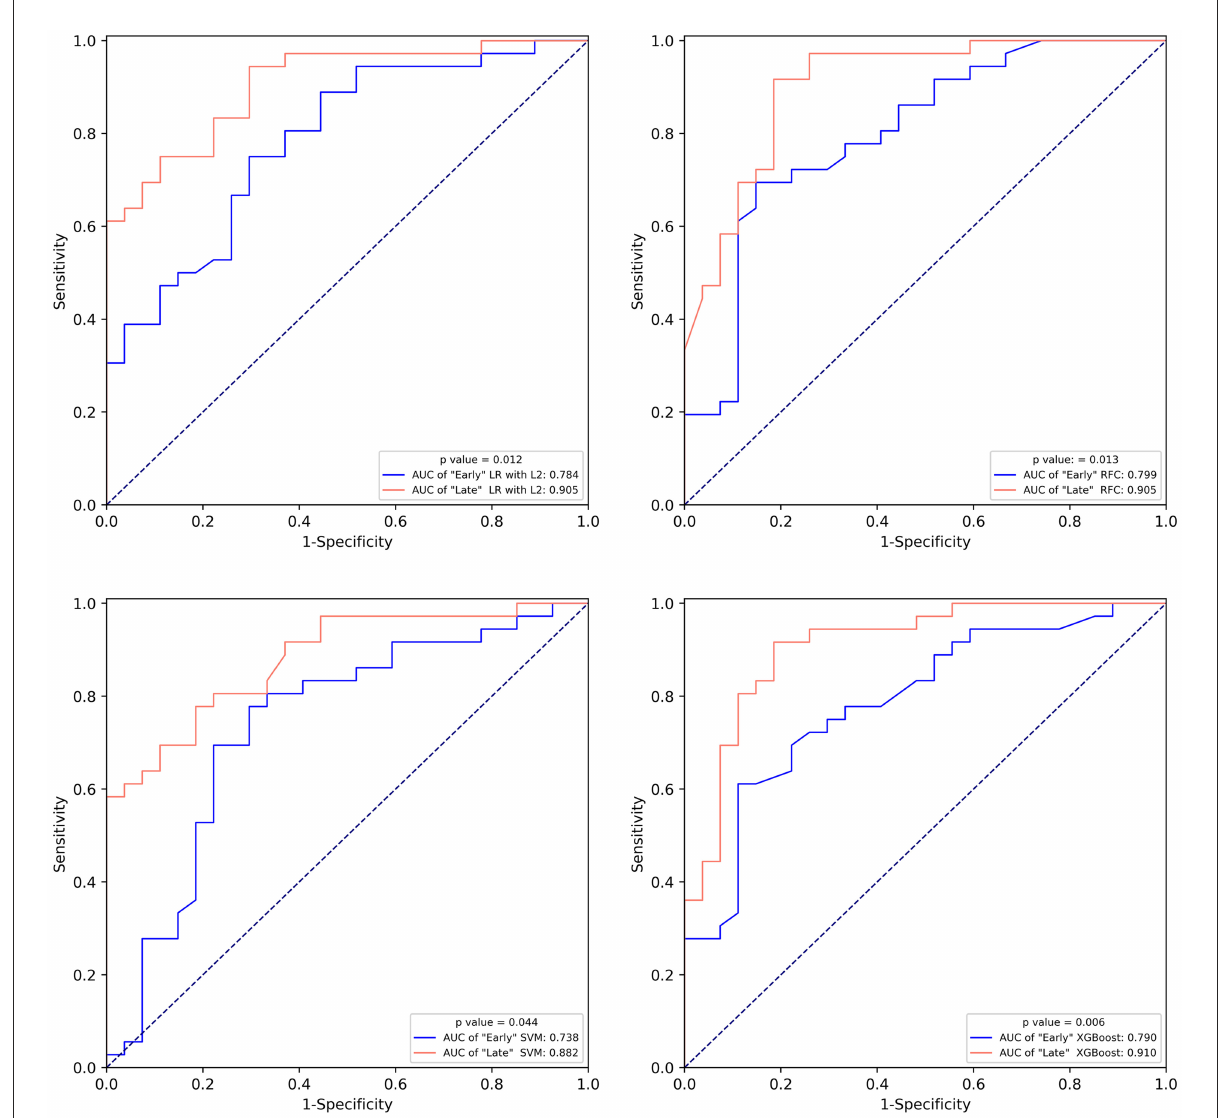
FIGURE4 The comparison of the receiver operating characteristic curve of “Early” machine learning models and “Late” machine learning models on the test set. LR with L2, logistic regression with L2 regularization; SVM, support vector machine; RFC, random forest classifier; XGBoost, extreme gradient